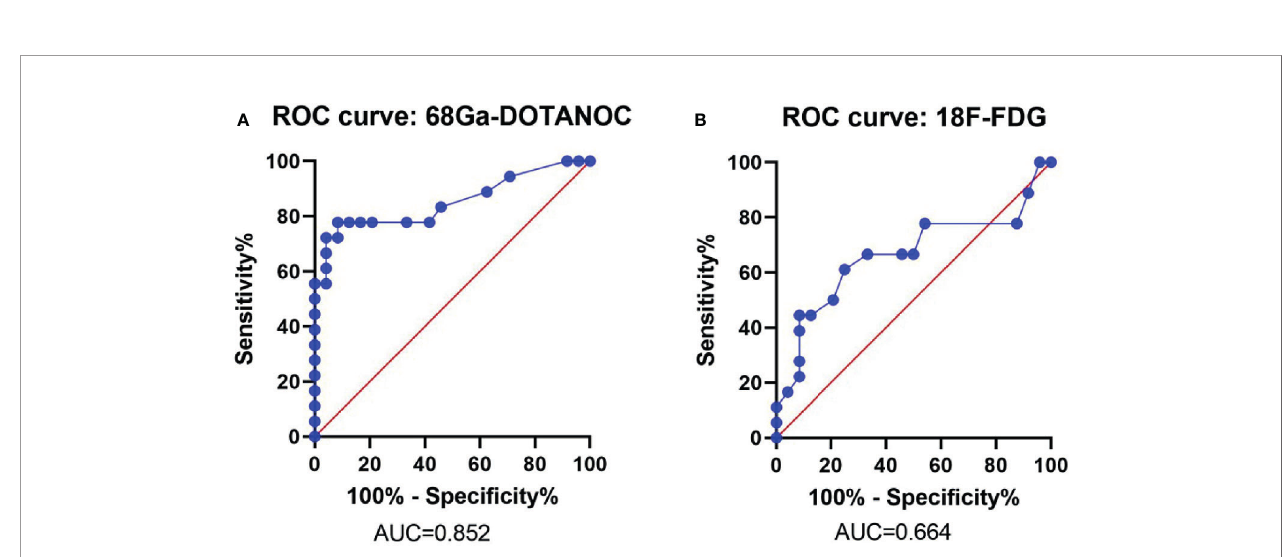
FIGURE 4 | ROC Curve of the SUVmax of 68Ga-DOTANOC and 18F-FDG PET in predicting LN group metastasis. ROC Curve of 68Ga-DOTANOC PET, The AUC was 0.852 (A) ; ROC Curve of 18F-FDG PET. The AUC was 0.664 (B) . ROC, Receiver Operating Characteristics; AUC, The area under the ROC